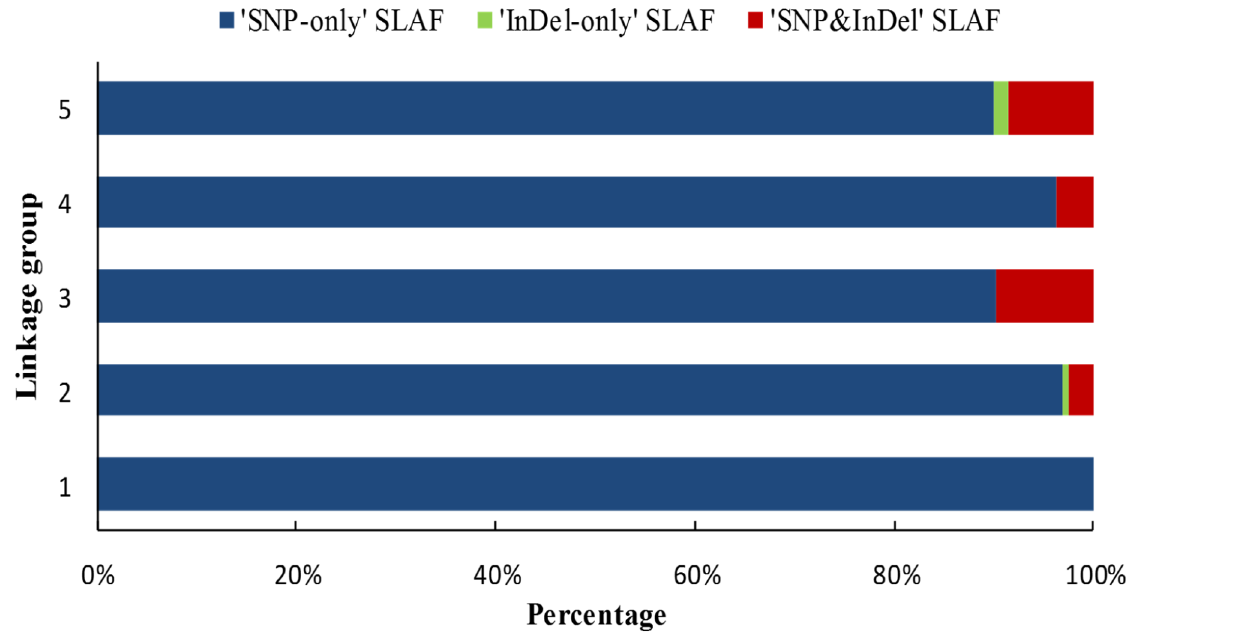
Fig 4. Percentages of diverse segregation distortion SLAF types on each linkage